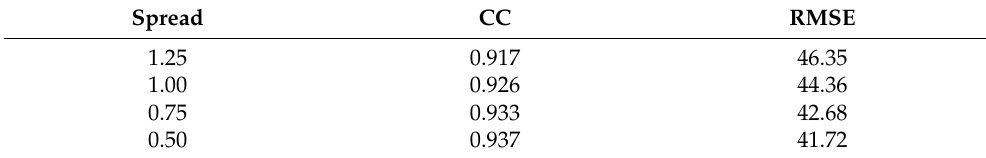
Table 3. Results of various value of parameter Spread in the GRNN model for scenario-2. Spread